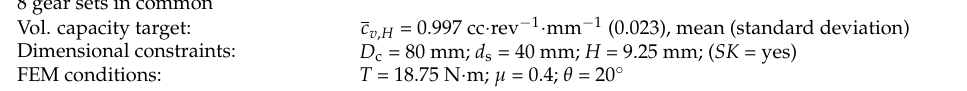
Table 5. The parameter design table of the second Taguchi experiment. (Please refer to Nomenclature section and Figure